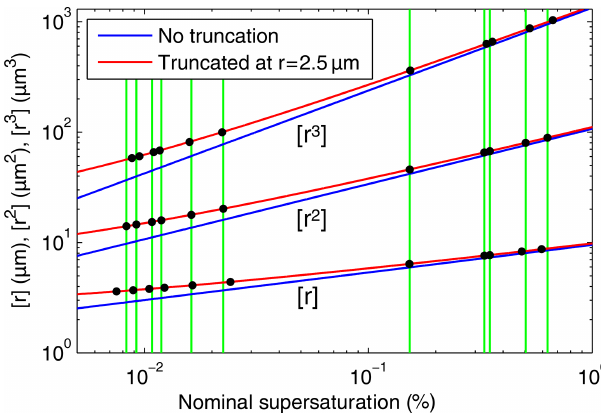
Figure 6. Mean radius, [ r ] , mean squared radius, [ r 2 ] , and cubed mean radius, [ r 3 ] , versus nominal mean supersaturation for h = 1m for DSDs with no truncation (blue) and for DSDs truncated at r = 2 . 5µm (red). The black dots indicate the nominal mean super- saturation values implied by [ r ] , [ r 2 ] , and [ r 3 ] obtained from 11 measured DSDs truncated at r = 2 . 5µm (Chandrakar et al., 2018b). The vertical green lines pass through the nominal mean supersatu- ration values implied by the measured [ r 2 ] values and allow a visual assessment of the consistency of the supersaturation values implied by the three measured moments for each of the 11